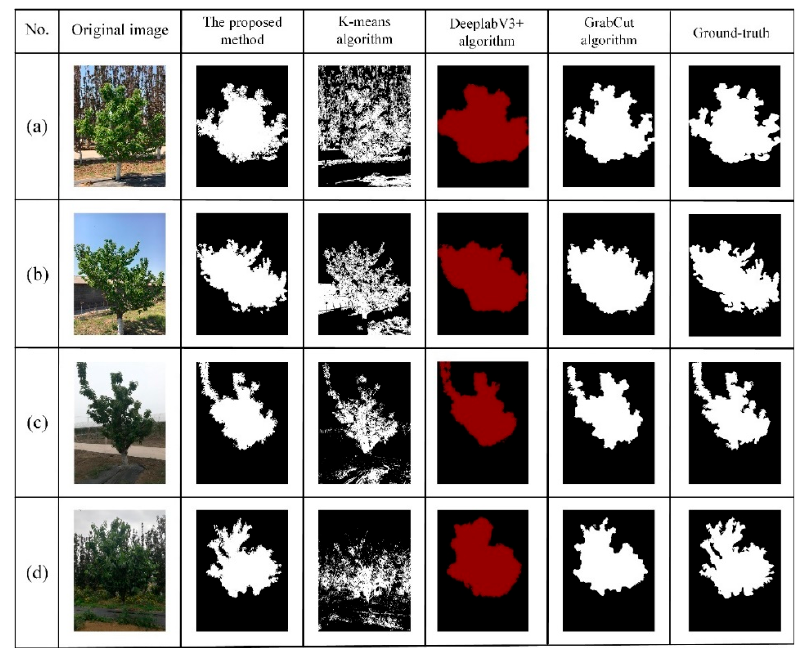
Figure 10. Comparison of different segmentation results: ( a ) sunny day and low-density weeds; ( b ) sunny day and high-density weeds; ( c ) cloudy day and low-density weeds; and ( d ) cloudy day and low-density weeds. From left to right are the original image, the result of the proposed method, the K-means algorithm’s result, the DeepLabV3+ algorithm’s result, the GrabCut algorithm’s result and the ground